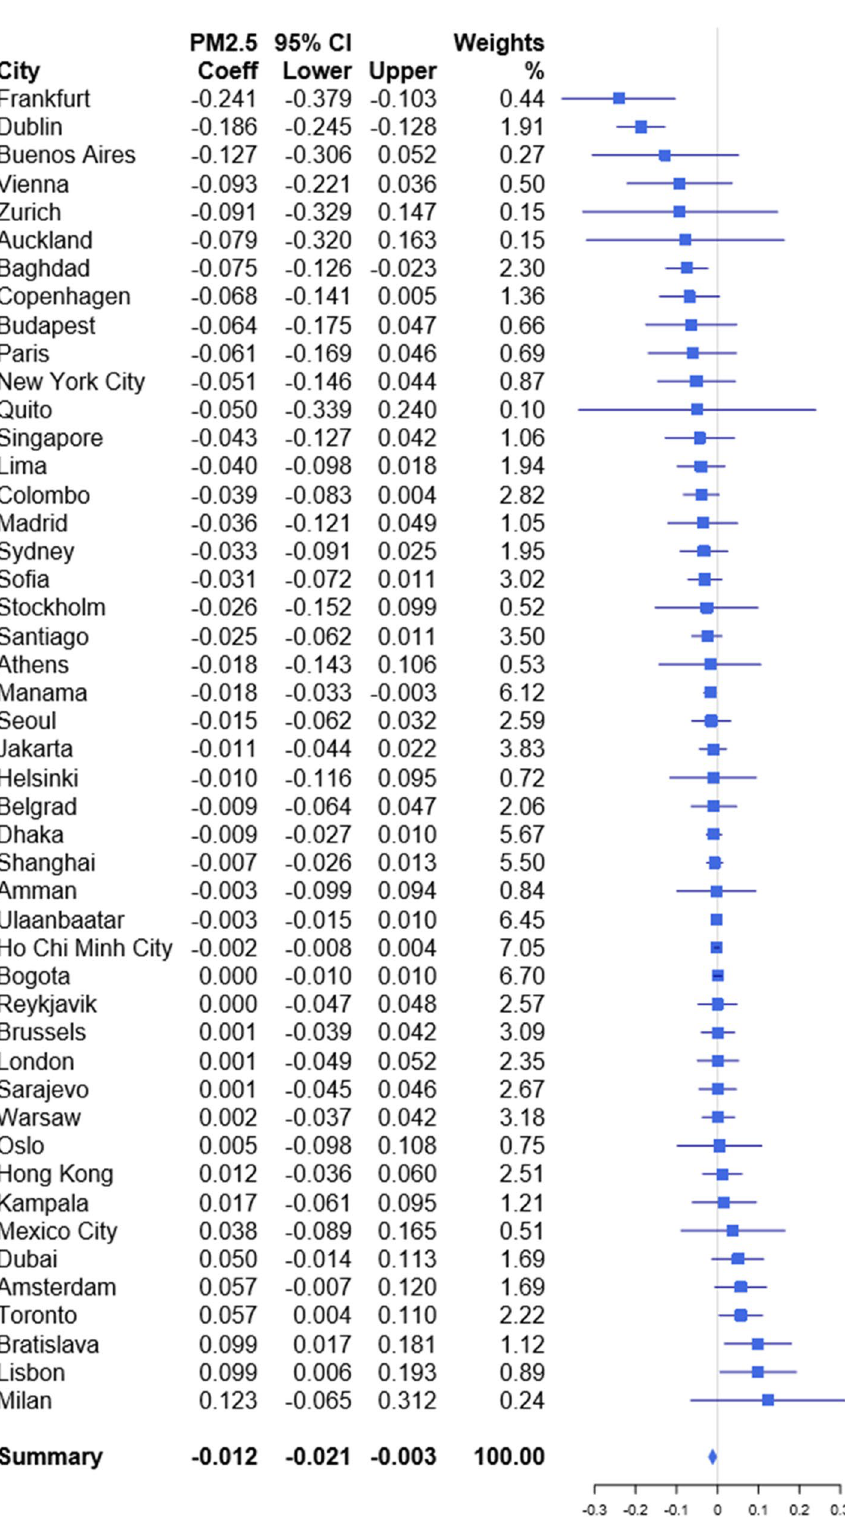
Figure 1. Regression coefficients and 95% confidence intervals for the association between 10 μg/m 3 increase in daily PM 2.5 concentration and stock index